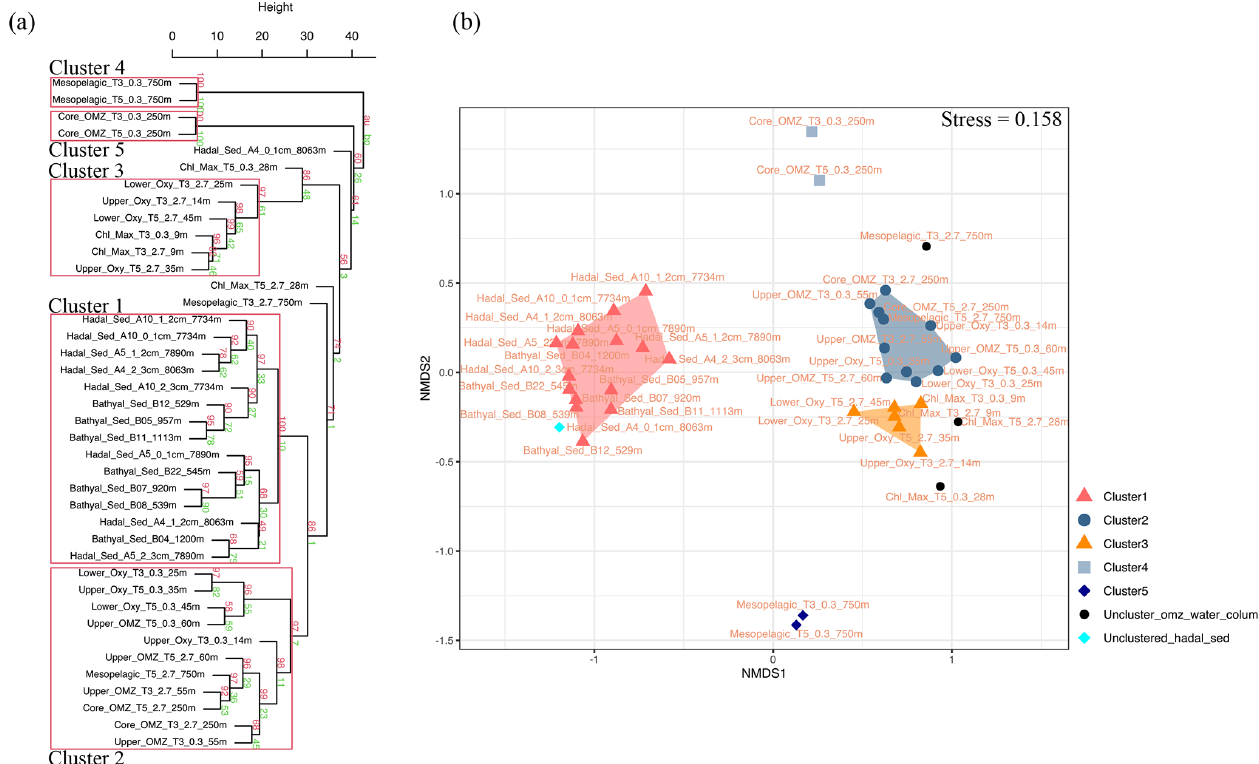
Figure 8. (a) Arithmetic mean (UPGMA) hierarchical clustering based on Euclidean distances calculated from IPLs in each sampling station. Red values are approximately unbiased (AU) p values, and green values are bootstrap probability (BP) for each node. Red boxes highlight clusters with 95% confidence. The number of bootstrap replicates is 10000. (b) Non-metric multidimensional scaling (NMDS) analysis of IPLs at each sampling station. The distance matrix was calculated based on the Bray–Curtis dissimilarity. The stress value of the final configuration was 15.8%. Different symbols and colors represent the sample grouping from hierarchical clusters shown in panel (a)